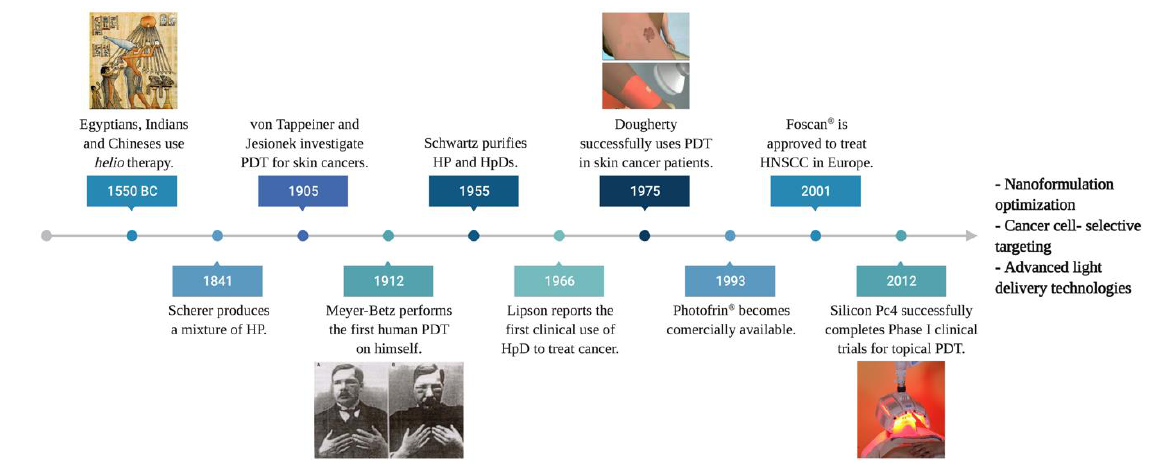
Figure 1. The developmental timeline of photodynamic therapy through the centuries. Abbr.: hematoporphyrin (HP), photodynamic therapy (PDT), hematoporphyrin derivative (HpD), head-and-neck squamous carcinoma (HNSC), phthalocyanine (Pc).